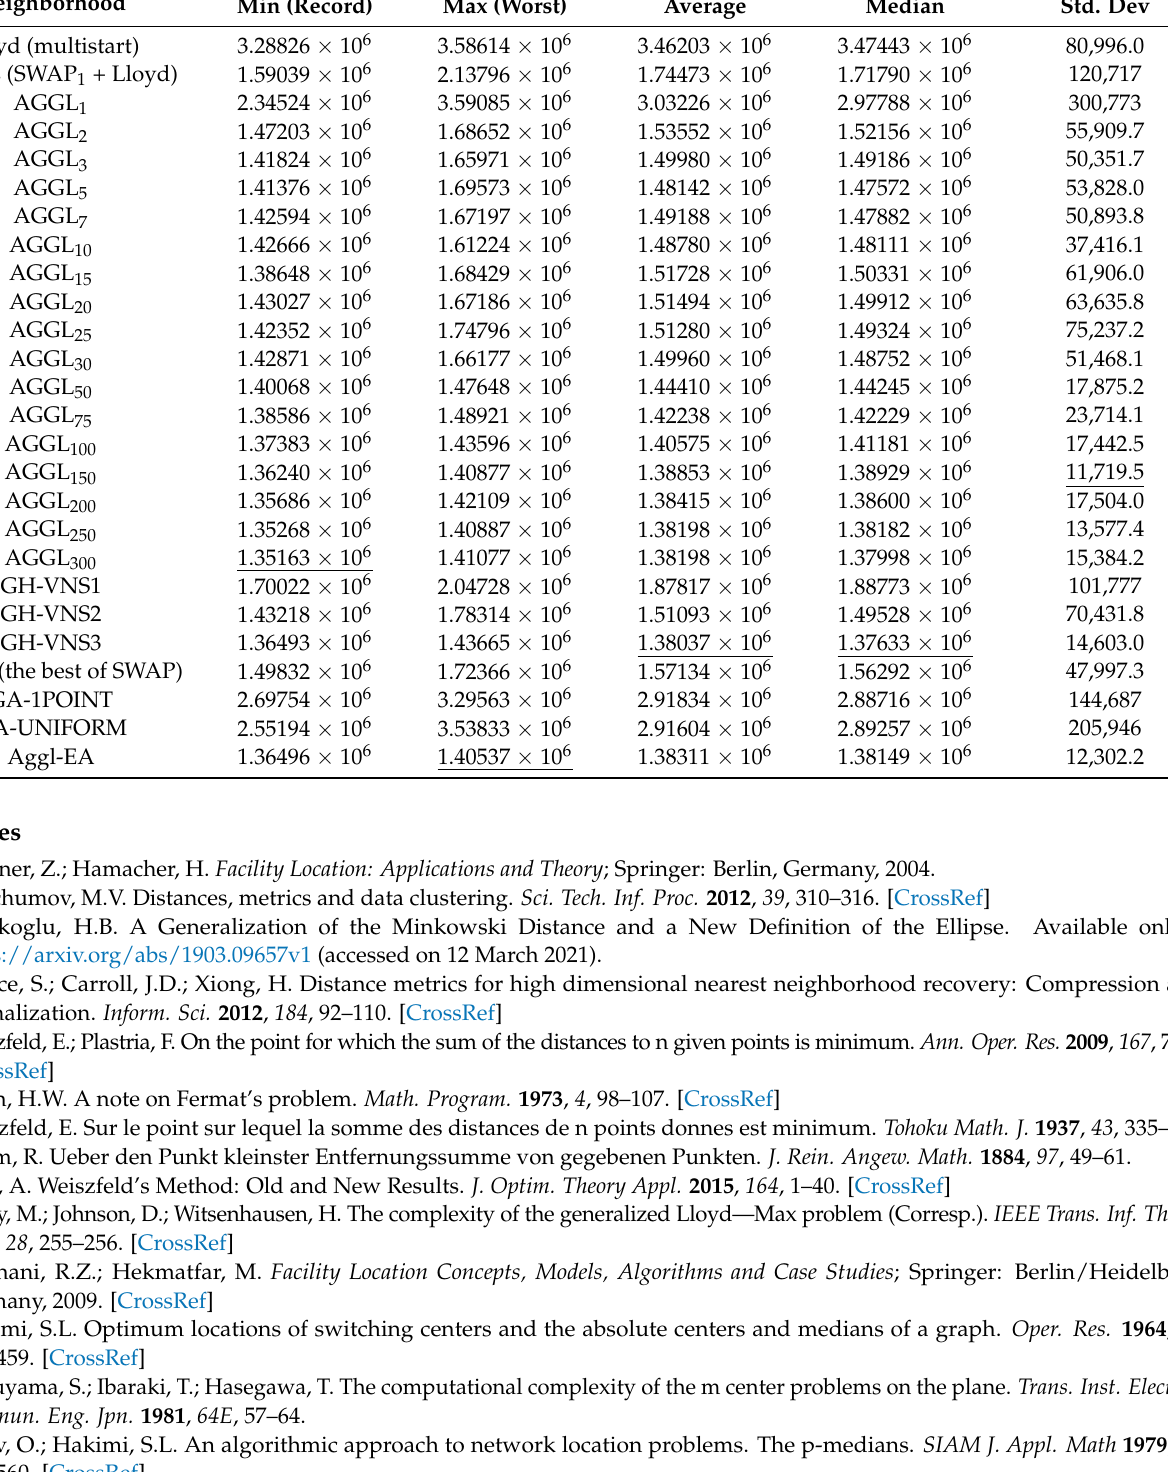
Table A15. Comparative results for Mopsi-Finland dataset. 13,467 data vectors in R 2 , p = 300 centers, time limitation 5 s. Algorithm